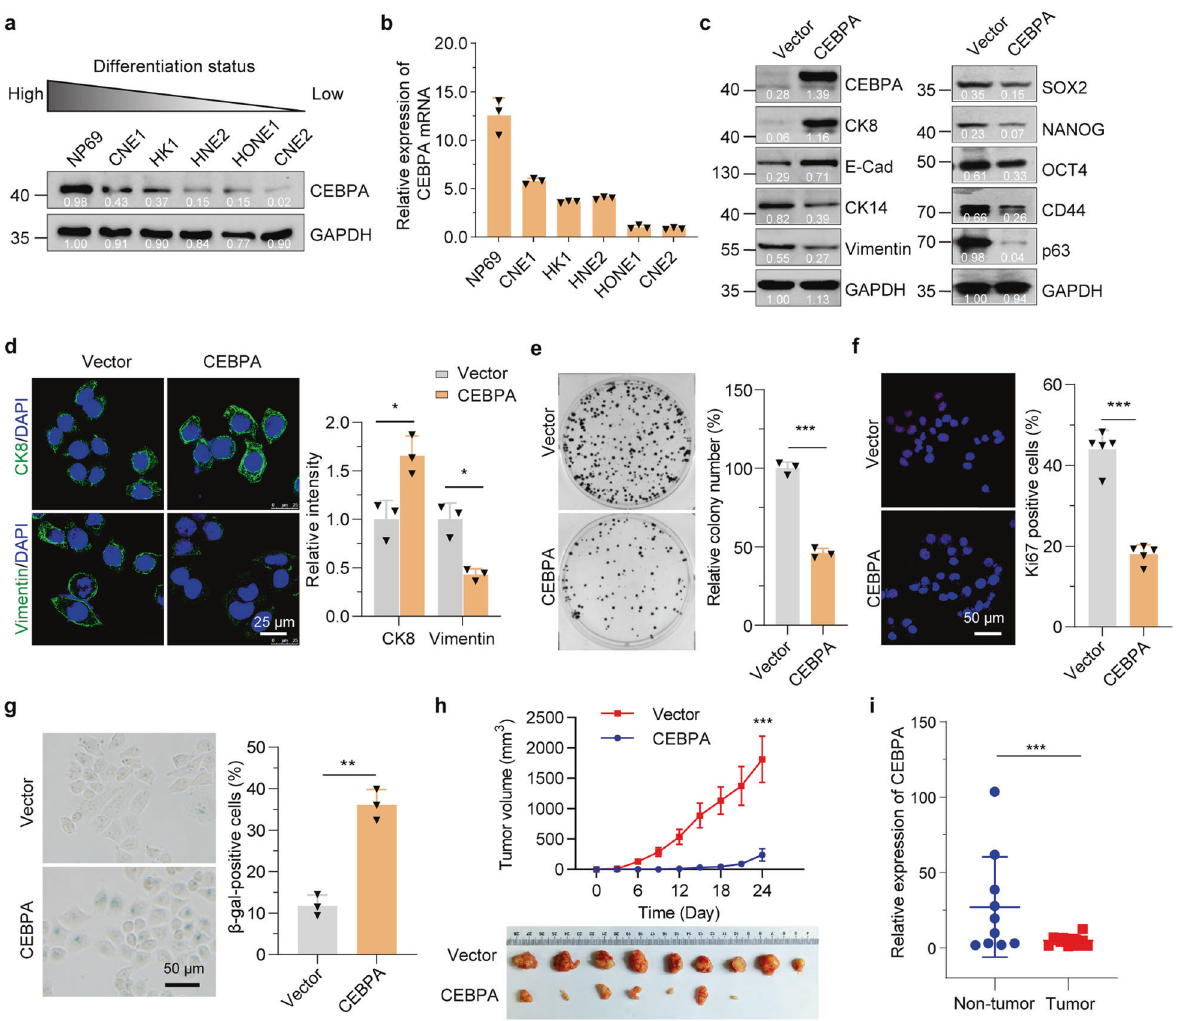
c Western blot with differentiation and stem-like markers in control (Vector) and CEBPA-overexpressed (CEBPA) CNE2 cells. d Immuno fl uorescence analysis with differentiation markers in control and CEBPA-overexpressed CNE2 cells. e Colony formation in control and CEBPA-overexpressed CNE2 cells. f Immuno fl uorescence staining for Ki67 in control and CEBPA-overexpressed CNE2 cells. g SA- β -gal staining in control and CEBPA-overexpressed CNE2 cells. h CEBPA-overexpressed and control CNE2 cells were injected into nude mice subcutaneously, and tumor volume was determined. i RT-qPCR analysis of relative CEBPA mRNA levels in patients ’ tumor tissues non-tumor nasopharyngeal tissues. Statistics ( d – i ), signi fi cance: * P < 0.05, ** P < 0.01, *** P < 0.001; two-tailed Student ’ s t